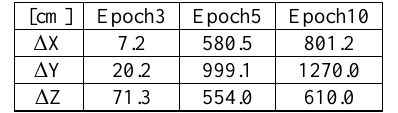
Table 6. The RMSE for RIBC for 10 unevenly distributed images.